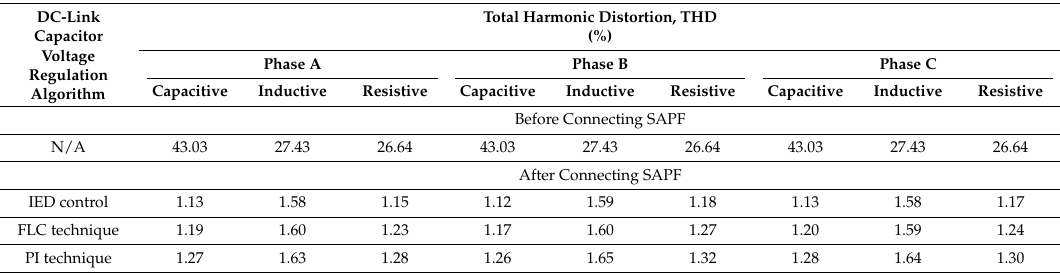
Table 5. THD values of source current i S in all phases resulted from SAPF utilizing each DC-link capacitor voltage regulation algorithm (Simulation